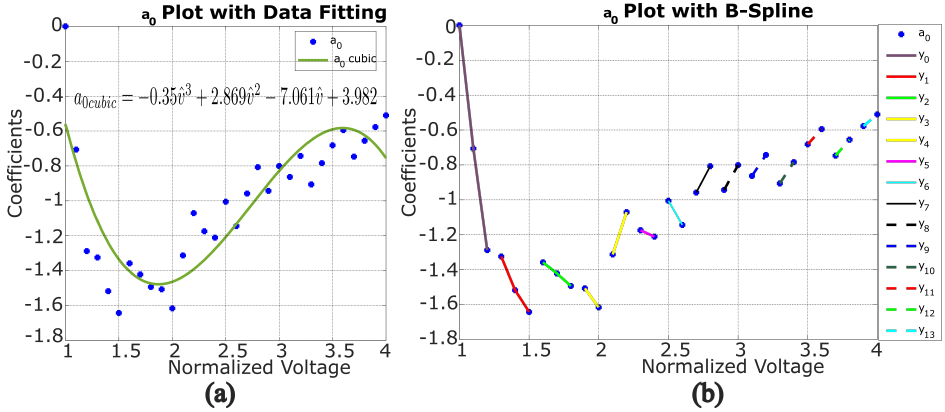
Figure 8. Illustration of a 0 plotting, data fitting and B-spline application; where ( a ) shows data fitting while ( b ) shows its equivalent B-spline representation. The application of B-spline results in the linear expressions displayed in Equation